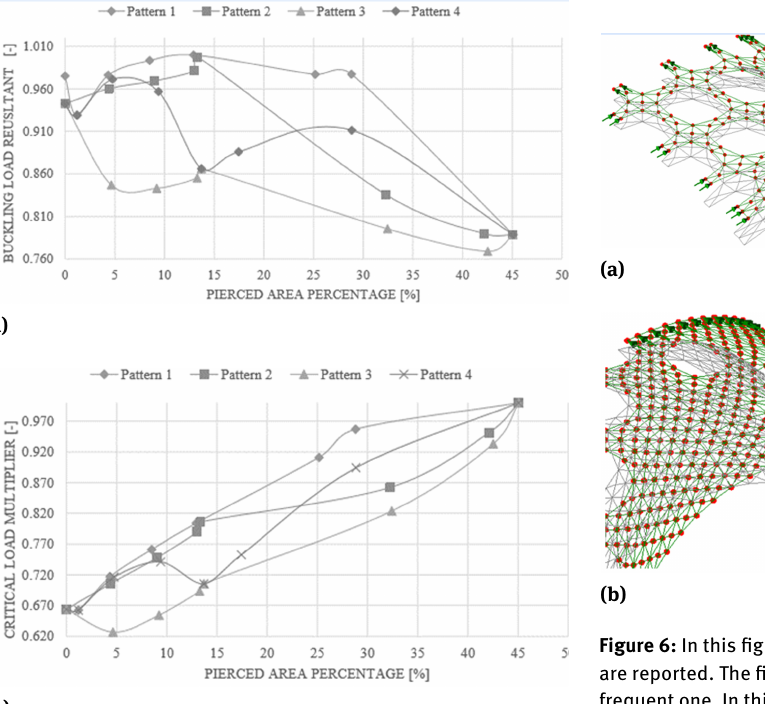
Figure 5: Normalized Buckling load for the four pattern evolutions considering the variation of the pierced area (a). Normalized critical load multiplier vs. pierced area percentage for the four pattern evolution (b)